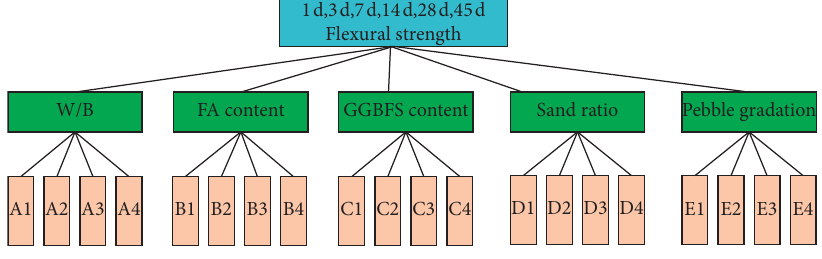
Figure 9: AHP model for the flexural strength